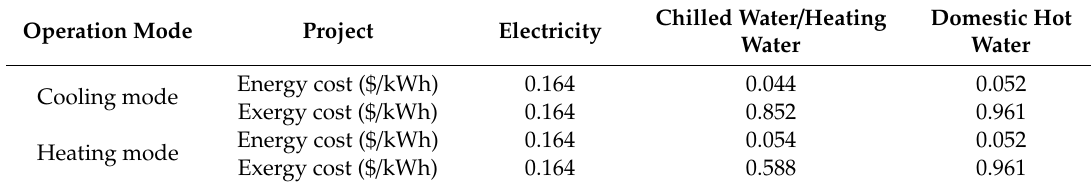
Table 5. Cost of products of the hybrid CCHP system in two operation